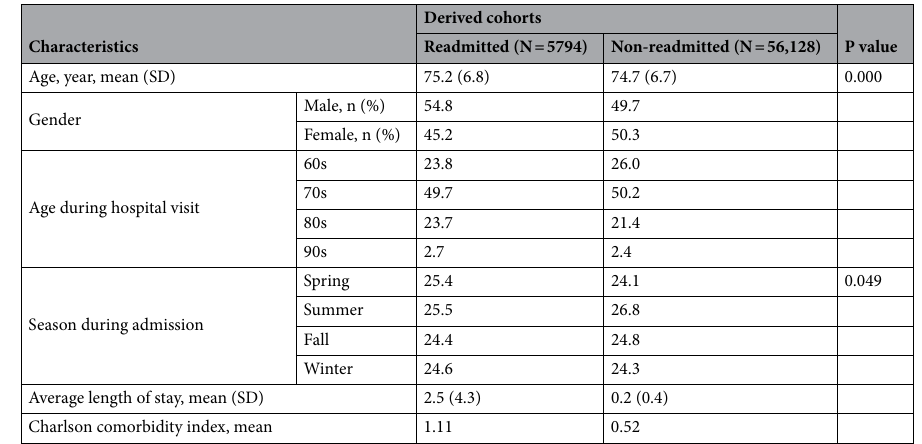
Table 1. Basic characteristics of study data for each visit type.